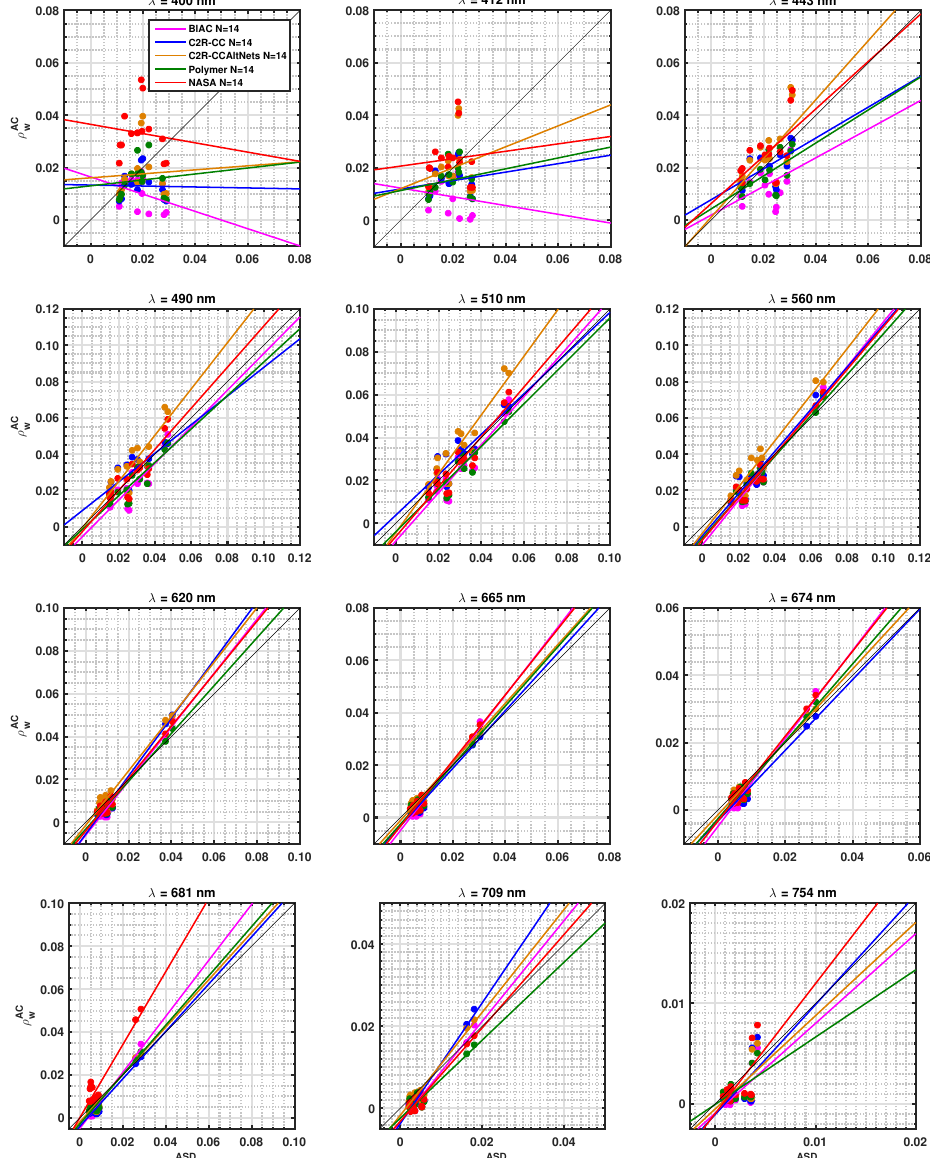
Figure 5. Scatterplots of the AC concomitant match-ups of the AC retrieval and the field measured water-leaving reflectance for 400, 412, 443, 490, 510, 560, 620, 665, 674, 681, 709, and 754 nm. In the multiple scatterplots figure, the field measured OCR ( ρ ASD w ) ) are represented in the x-axis and the water-leaving reflectance AC retrieval ( ρ AC w ) ) are represented in the y-axis. The black solid lines represent the 1:1 line. The colored solid lines show the linear regression lines between the field-measured and AC retrievals of ρ w . The color code is similar to that in Figure 3, and the number of match-ups is indicated in the text box of the left-top scatterplot ( λ = 400